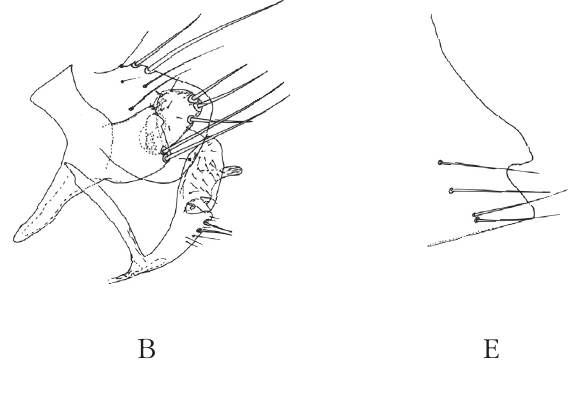
 (Figure 4C) et Lophuromys f. margarettae (= L.